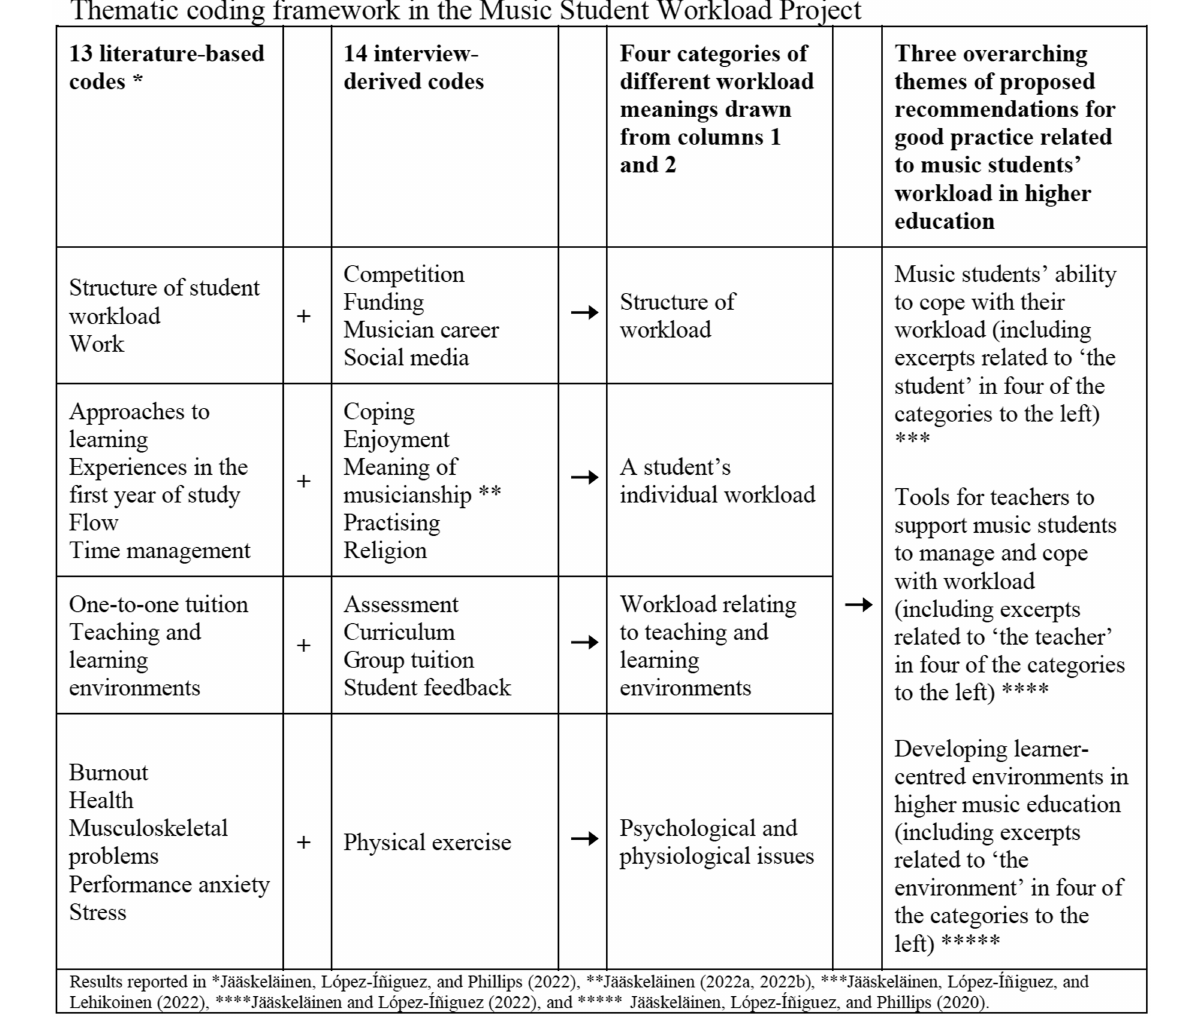
FIGURE 3 Music Student Workload Project’s thematic coding